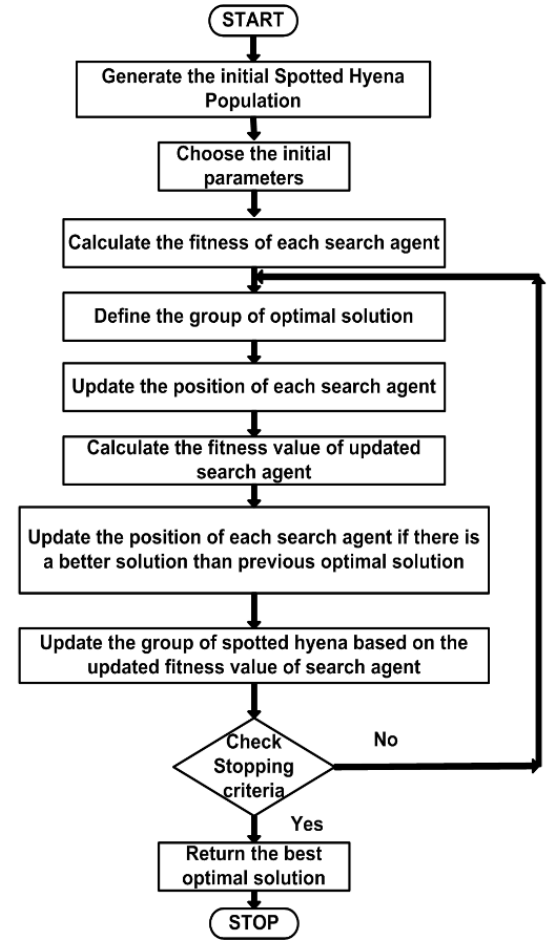
Figure 4. Flowchart of the SHO algorithm.